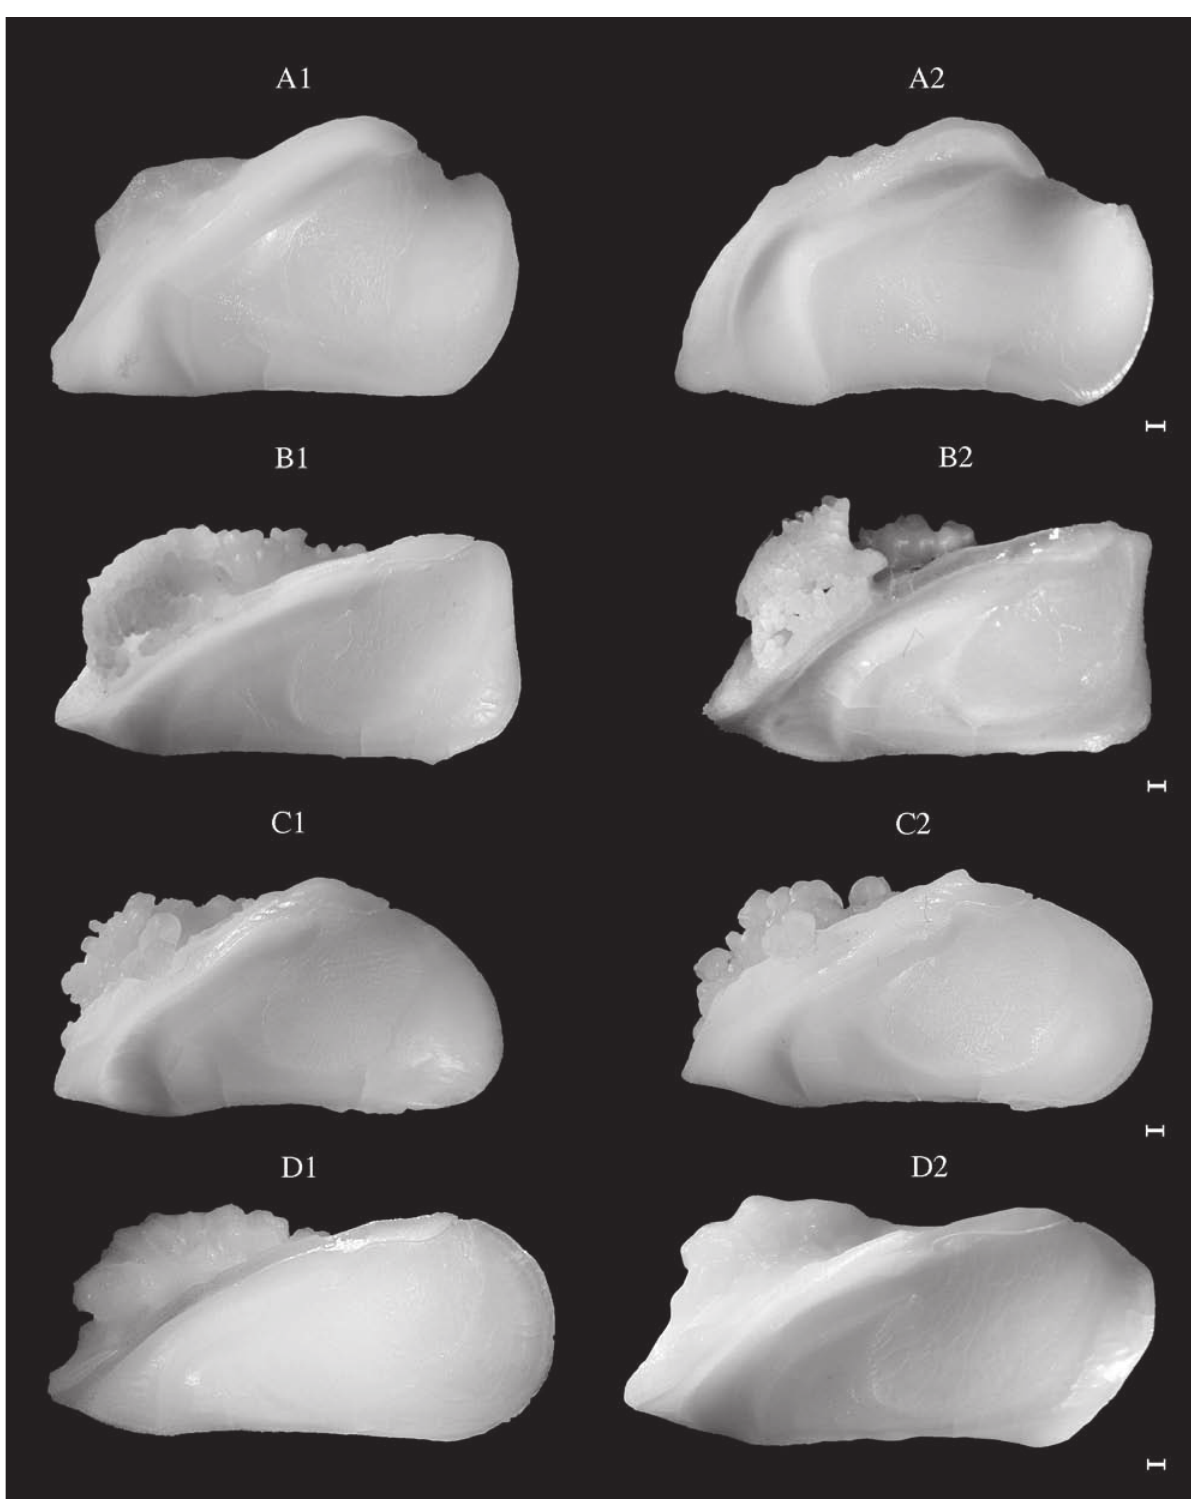
Fig. 64. – Pseudotolithus elongatus (CEA) . SL, A1, 47.9 cm; A2, 48.1 cm. Pseudotolithus senegalensis (CEA). SL, B1, 47.0 cm; B2, 50.6 cm. Pseudotolithus senegallus (CEA). SL, C1, 47.0 cm; C2, 48.9 cm. Pseudotolithus typus (CEA) . SL, D1, 52.6 cm; D2, 54.2 cm. Scale bar = 1